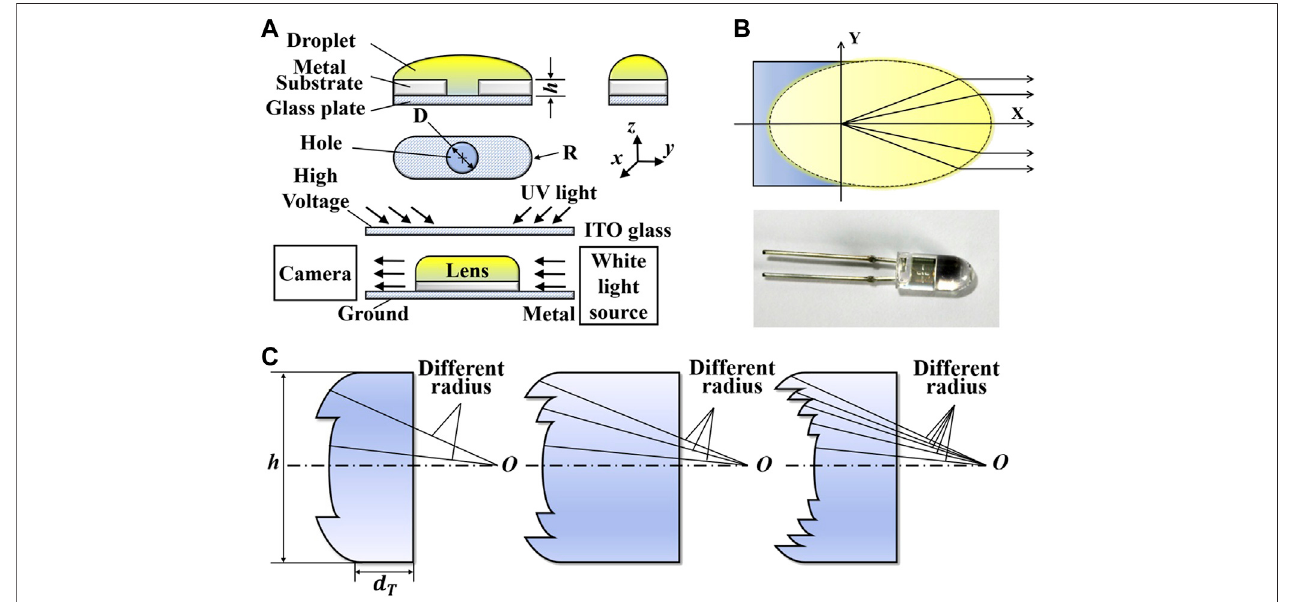
FIGURE 3 | Innovative collimators: (A) Manufacturing method of UV curing adhesive collimator. Adapted from [7]; (B) Model and packaging form of the ellipsoidal collimating lens. Adapted from [8]; (C) Variable curvature radius SAC with the different number of divisions. Adapted from